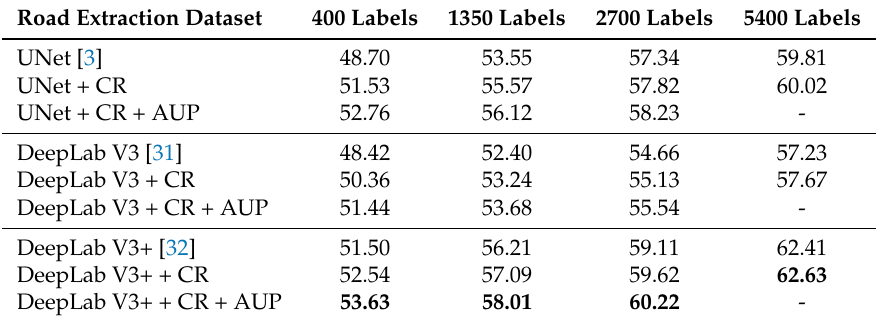
Table 3. Segmentation accuracy (mIoU, %) comparison of CR and AUP in our method on Road Extraction dataset when different network structures are adopted.